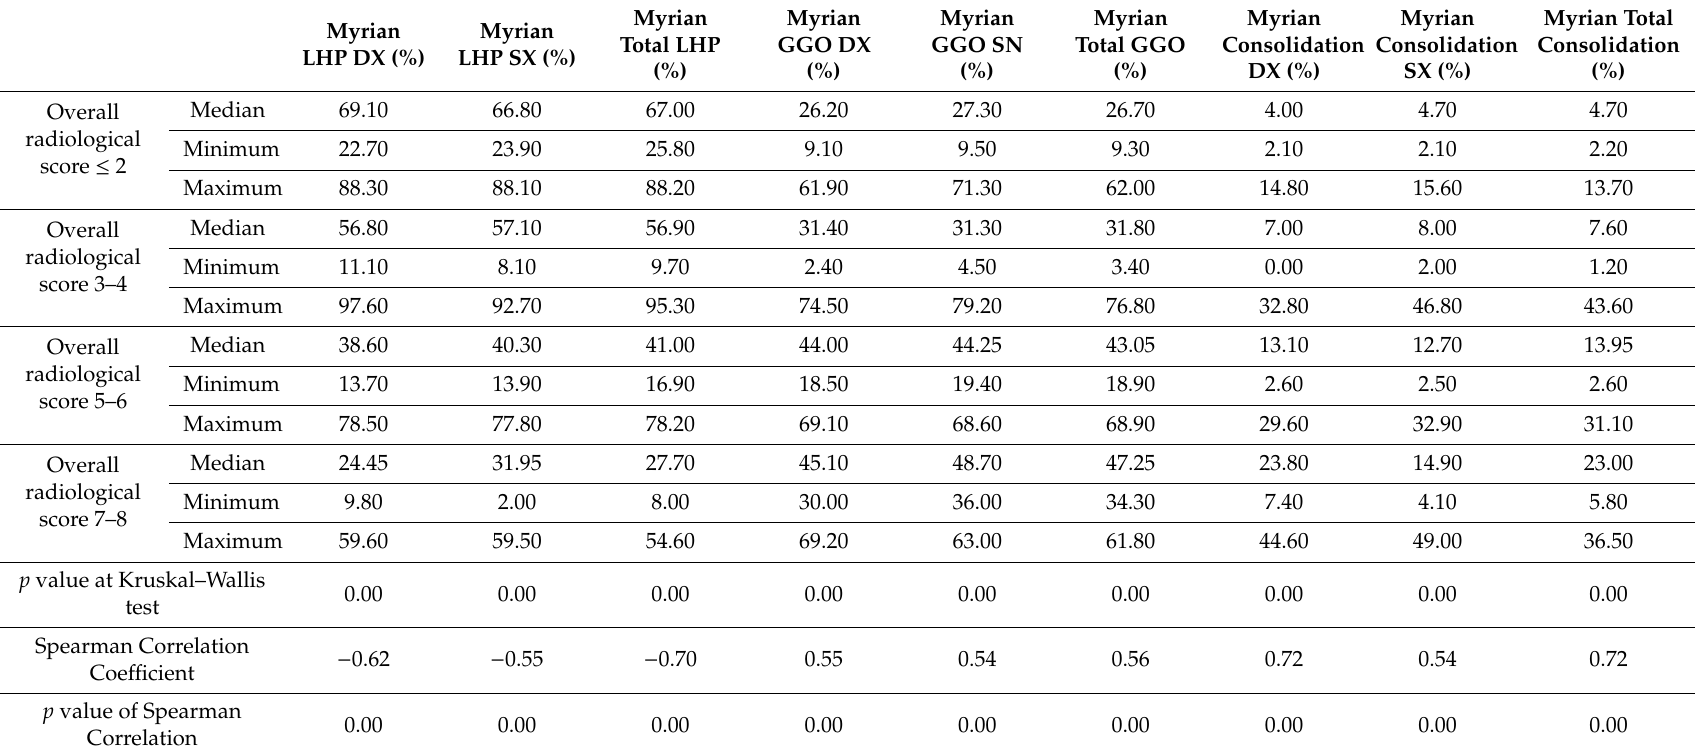
Table 5. Myrian quantitative results compared with radiological